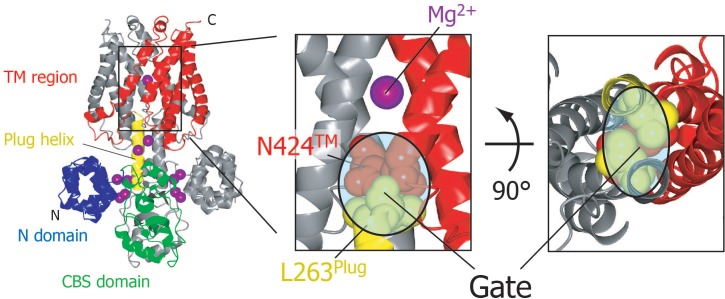
Gate region of MgtE.MgtE structure in the Mg2+-bound, closed state (PDB code: 2ZY9) is shown in the same colour scheme as in Figure 1A. L263 residues in the C-termini of the plug helices and N424 residues in the TM helices are shown as red and yellow spheres, respectively. The direct interaction between these residues closes the ion- conducting pore at its cytoplasmic side; thus, this region is assumed to function as a gate in MgtE.